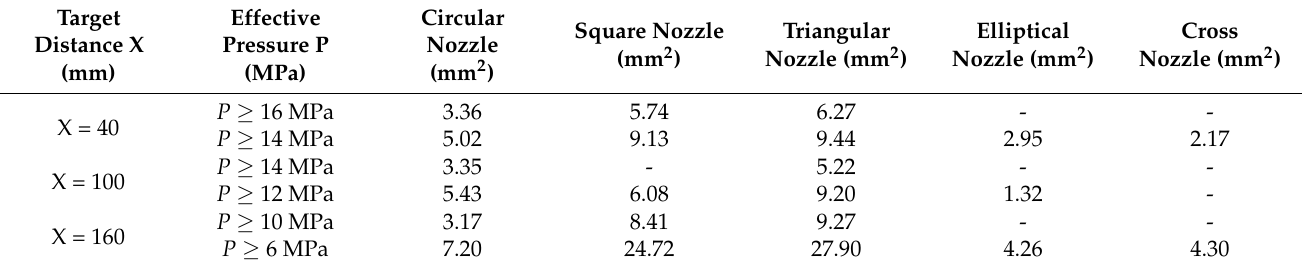
Table 6. Effective impact area of 5 nozzles at different target